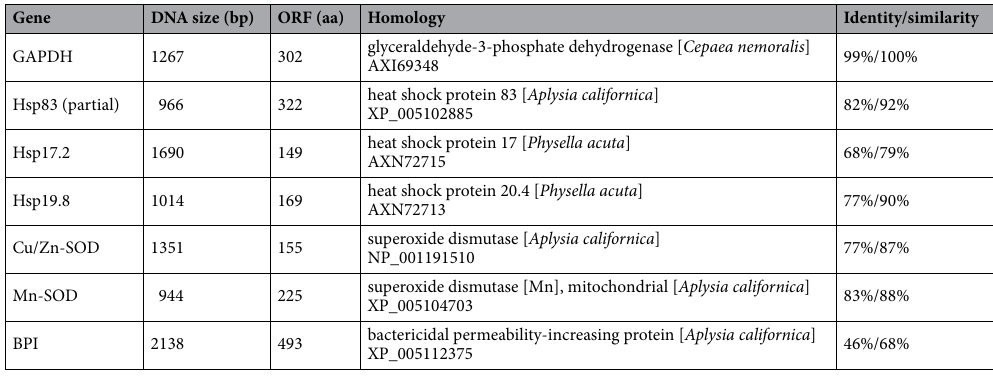
Table 2. Sequences characteristics and